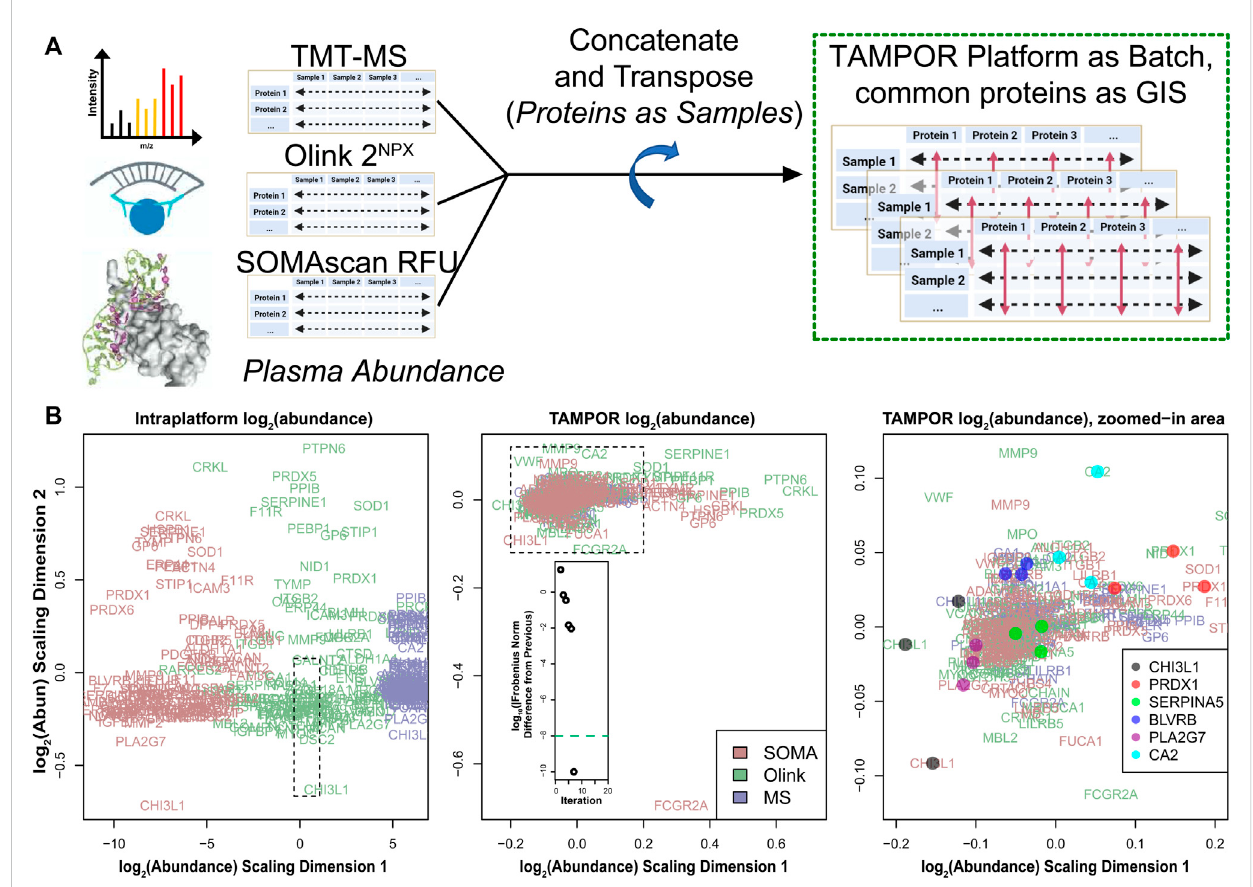
FIGURE 5 Use case 4: TAMPOR correction of multi-platform blood plasma proteomic data. (A) Protein measurements were collected on three platforms: TMT-MS, Olink, and SOMAScan, and minimally batch corrected within platform (i.e., using naïve ratio for TMT-MS, NPX normalization for Olink, and batch-correctedrelative fl uorescence units(RFU)forSOMAscan).Thedatawerecombinedintoasingle matrixwithstrongbatcheffectsdue toplatform, and the matrix transposed to place assays of protein isoforms as columns and samples as rows. 35 sample measurements were kept, replicated for the same samples on each of the platforms. None of the 9,057 protein assays had any missing values. (B) One hundred and one protein isoforms were common to all 3 platforms representing 101 gene product protein measurements across the 35 samples. A MDS plot of their variance indicates stark separationoftheassay measurementsbyplatformalongthe fi rstdimensionofseparationinuncorrectedlog 2 abundance( left ).Thedashedboxindicates the border of the following plot. Center , after TAMPOR of the transposed data, the 303 assays have a focused, tightly overlapping distribution about a common central focus at the origin of the MDS plot. Inset , TAMPOR converged in 7 iterations. Right , further zooming into the area represented by the dashed box in the middle panel, and adding points for selected assay triplicates on the 3 different platforms for 6 separate protein isoforms quanti fi ed in the TAMPOR abundance matrix indicates close proximity of most triplets in the MDS plot